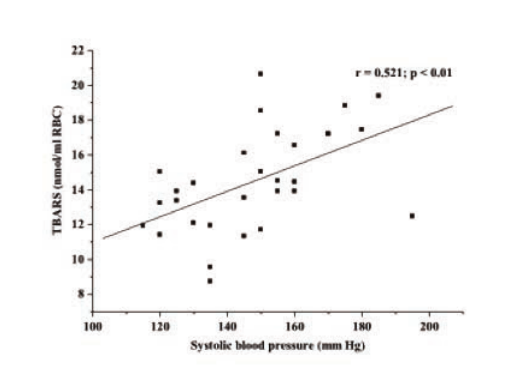
Figure 3. Correlation between TBARS in RBC and systolic pressure.